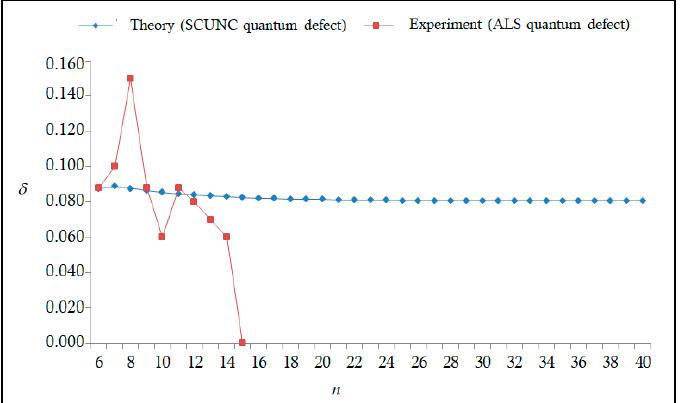
Figure 1. Variations of the quantum defect ( δ ) with the principal quantum number n for the 4 s 2 4 p 2 ( 1 D 2 ) nd ( 2 S ) Rydberg series originating from the 2 P ° 3/2 metastable state of Se + converging to the 1 D 2 series limit in Se 2+ .